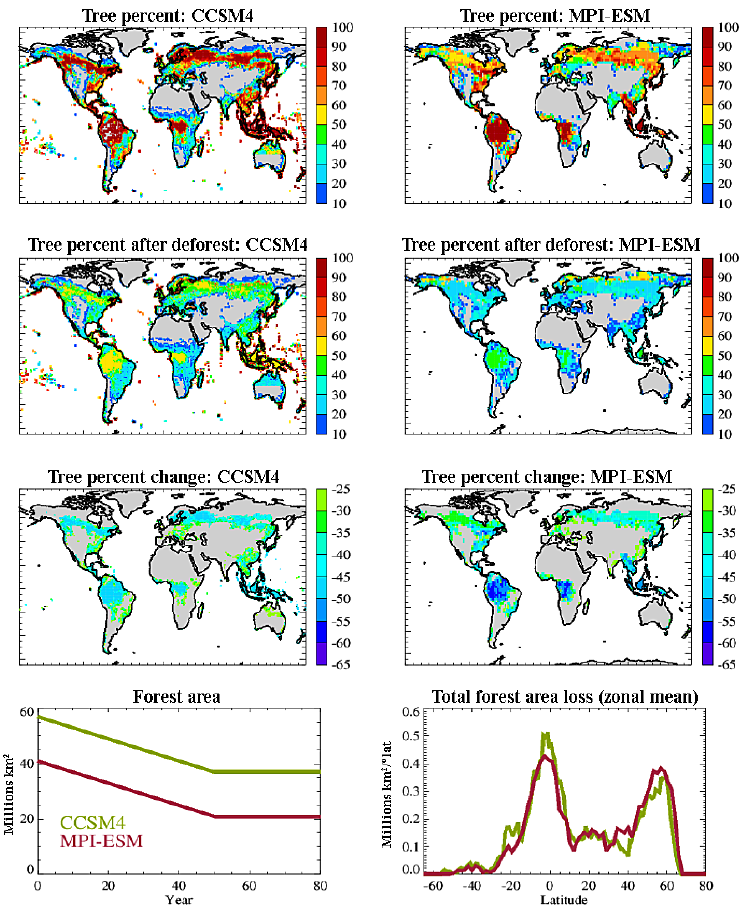
Figure 3. Sample maps of fraction of grid cell covered by trees at the start of the idealized deforestation simulation, after idealized defor- estation (year 50), and the change in tree fraction by the end of the deforestation period. Time series of forest area and zonal mean forest area loss are also shown. Examples are shown for two typical CMIP5 models with strongly differing initial forest cover. Even with the different initial forest cover, the deforestation patterns and amounts are broadly equivalent across the two